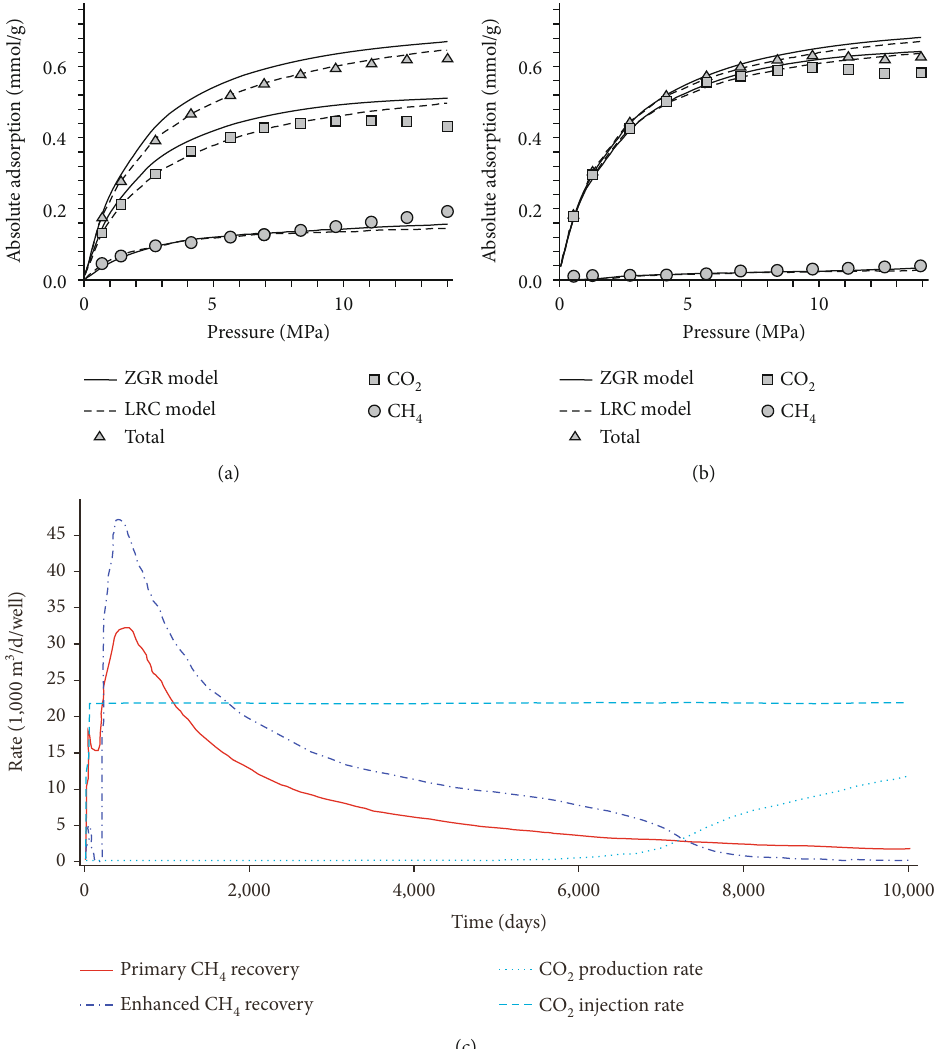
/CO feed mixture on a wet Ti ff any mixed-coal sample at 327.6K. (b) 4 2 /CO feed mixture on a wet Ti ff any mixed-coal sample at 327.6 K. (c) Predicted rates for 2 2 injection scenario. (Modi fi ed from Fitzgerald et al. [62] and Sander et al. 2